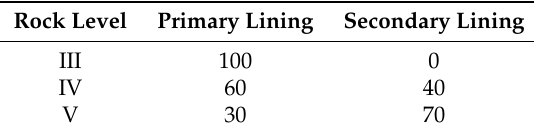
Table 3. Load-sharing ratio during tunnel construction.